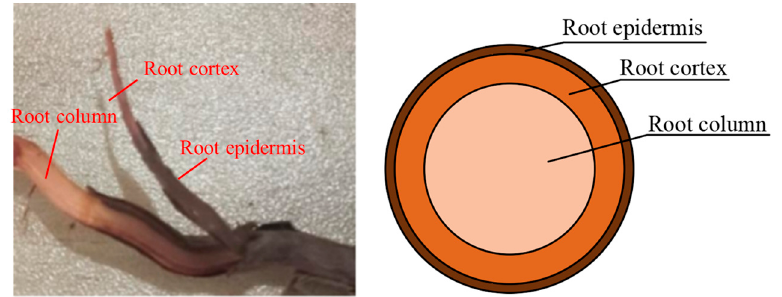
Figure 7. The sectional structure of Chinese fir root.